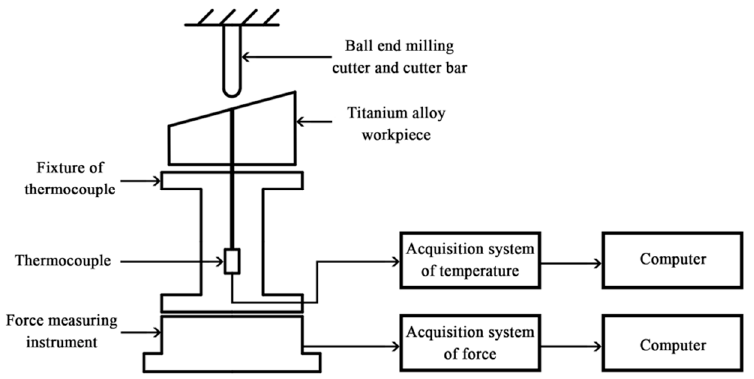
Figure 1. Approach to measuring the milling temperature.